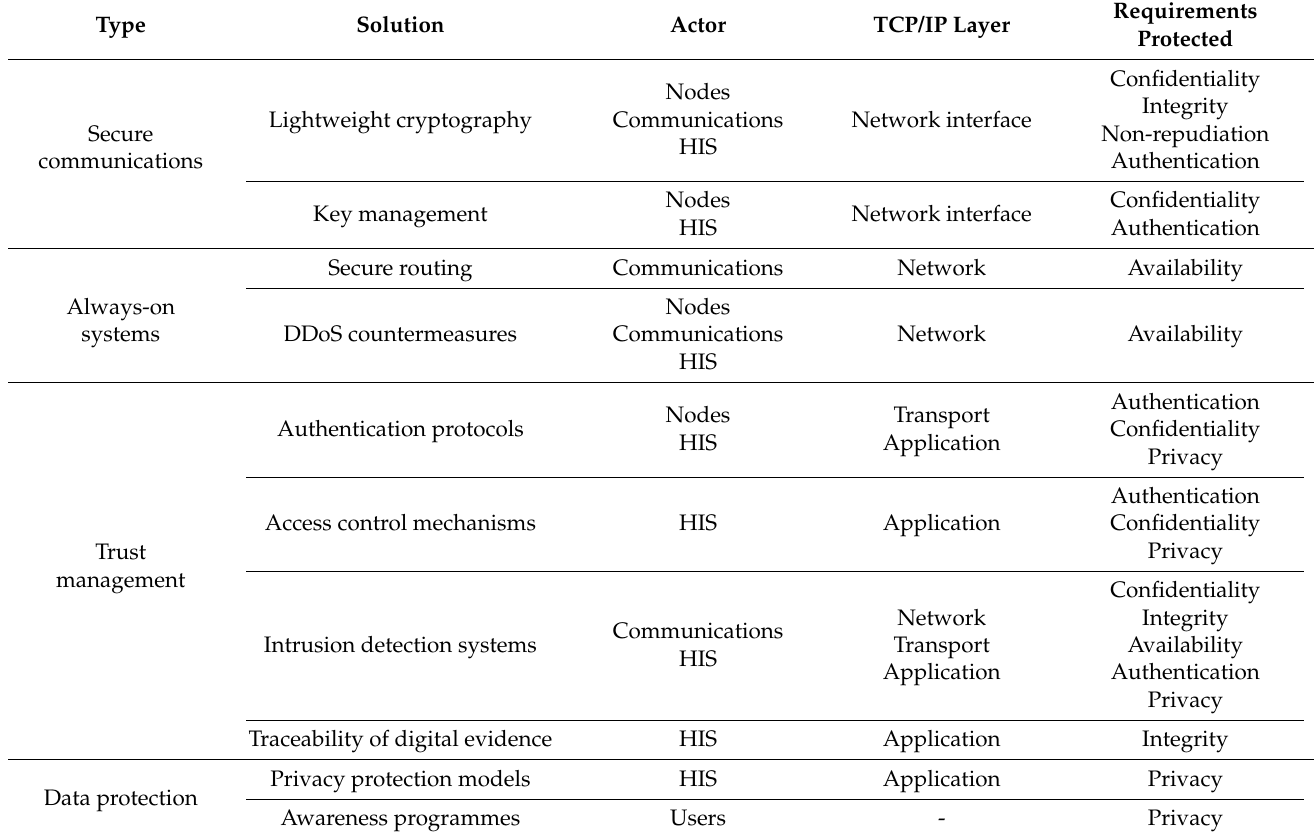
Table 14. Summary and classification of security solutions in smart healthcare